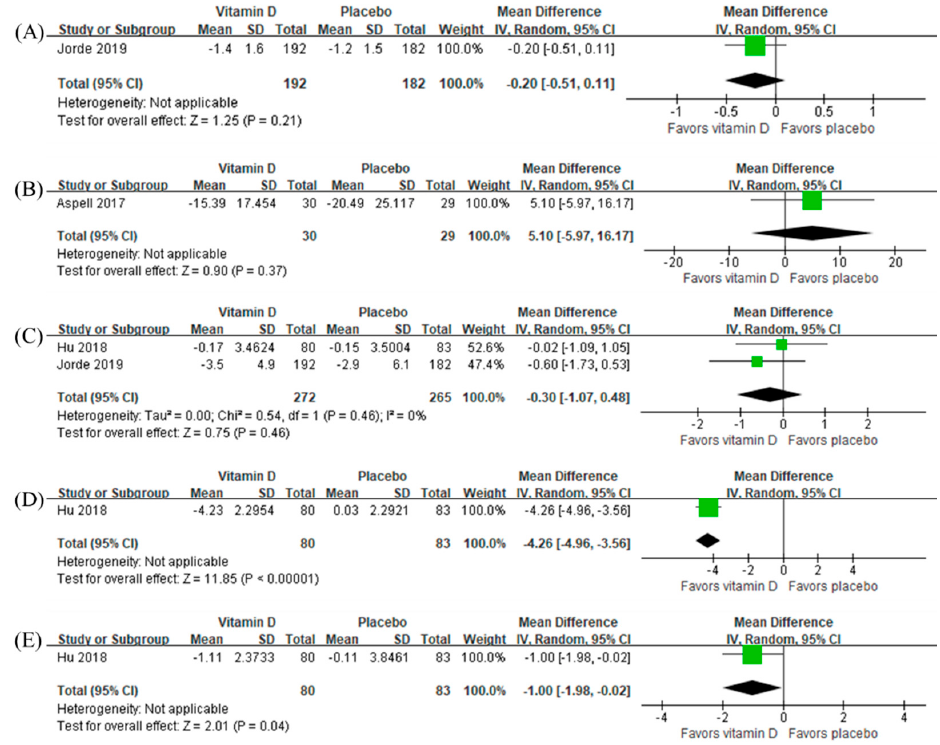
Figure 6. Effect of vitamin D on (A) episodic memory, (B) executive function, (C) processing speed, (D) attention, and (E) visuospatial function in terms of change from baseline.